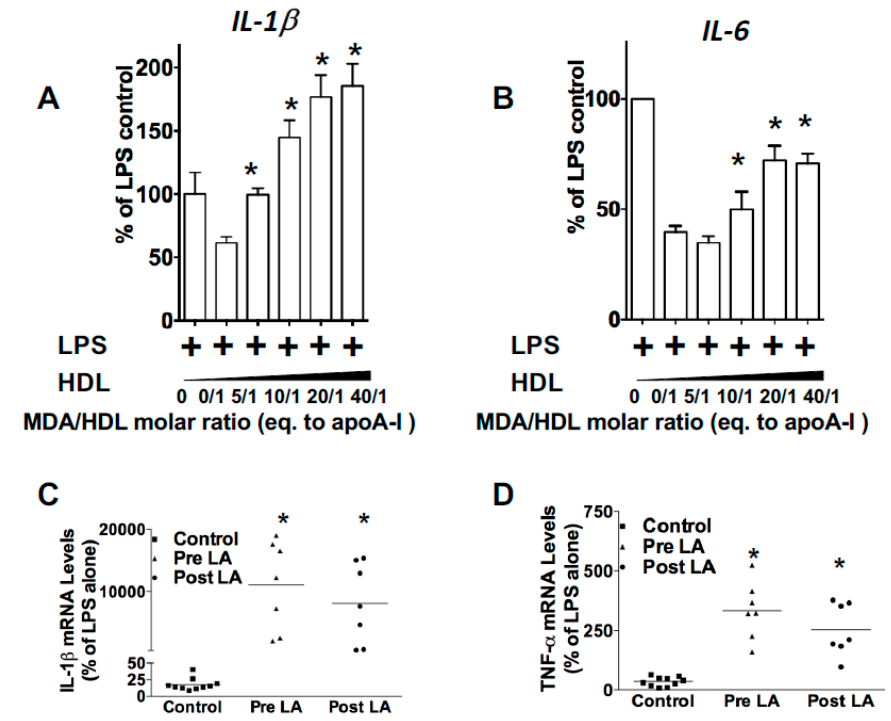
Figure 6. MDA-modified HDL increases expression of pro-inflammatory genes and FH-HDL exerts remarkable pro-inflammatory properties on Apoe − / − macrophages. HDL was modified with increasing doses of MDA and the effects on macrophage expression of IL-1 β ( A ) and IL-6 ( B ) in response to LPS were measured. Graphs represent data (mean ± SEM) of the experiments; * p < 0.05 is indicated by comparing with HDL treatment group ( A , B ) using one way ANOVA. IL-1 β ( C ) and TNF- α ( D ) mRNA levels were measured in Apoe − / − macrophages treated with LPS and HDL from control (n = 9) and FH subjects (n = 7) pre- and post-LDL apheresis. * p < 0.05 is indicated by comparing with control group ( C , D ) using one way ANOVA.